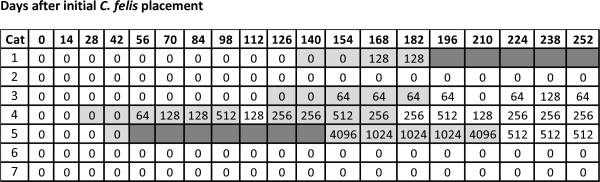
Bartonella henselae antibody and PCR assay results in 7 untreated cats (R1) exposed to C. felis allowed to feed on cats with B. henselae infection induced by IV inoculation. Light gray shaded areas indicate samples that were PCR positive; Dark gray areas indicate the days on which the cats were removed from the room because of fever and need for supportive care; exposure to C. felis began on Day 0. None of the PCR negative cats were blood culture positive.